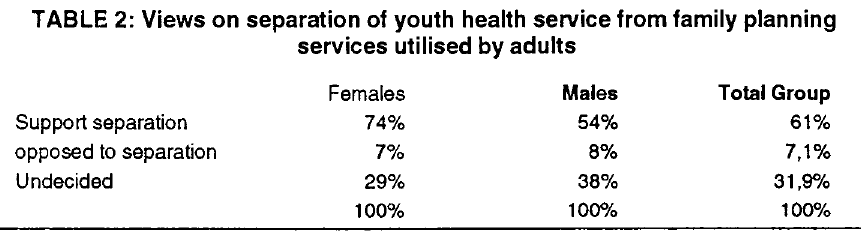
TABLE 2: Views on separation of youth liealth service from family planning services utilised by adults